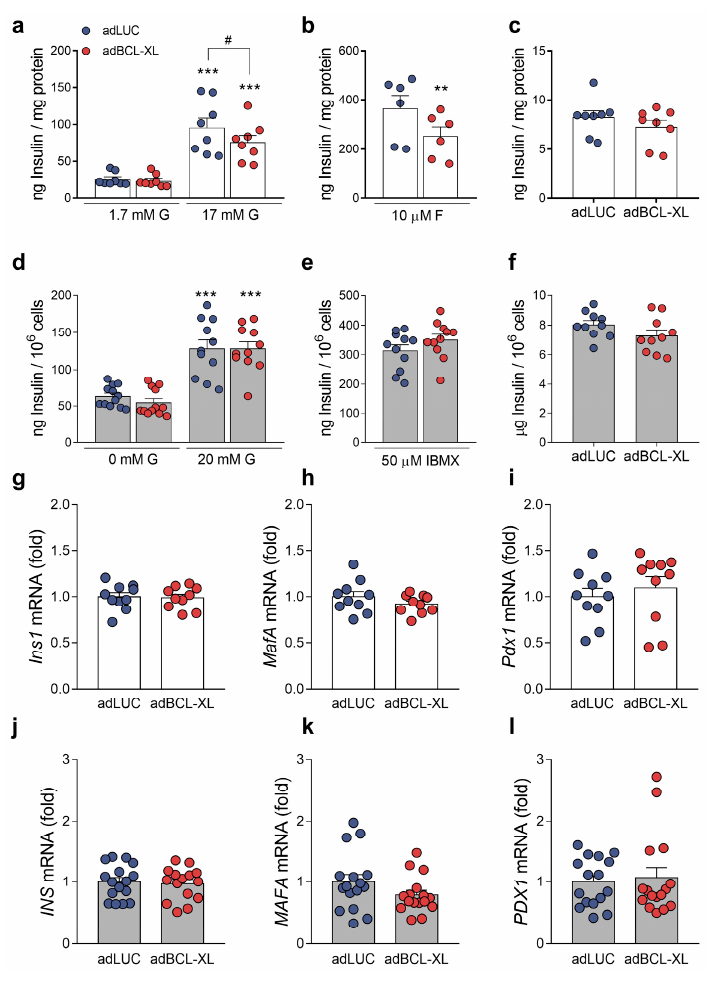
Figure 3. BCL-XL overexpression decreases insulin secretion in rat but not in human β -cells. INS-1E ( a – e , white bars) and EndoC- β H1 cells ( f – j , grey bars) were infected with adenoviral (ad) vectors encoding luciferase (adLUC, blue dots) or rat BCL-XL (adBCL-XL, red dots). After 48 h of recovery, glucose-stimulated insulin secretion was assessed. ( a , b ) Insulin secretion was measured at 1.7 and 17 mM glucose ( a ) or 17 mM + 10 μ M Forskolin (10 μ M F) ( b ). ( d , e ) Insulin secretion was measured at 0 and 20 mM glucose ( d ) or 20 mM + 50 μ M IBMX ( e ). ( c , f ) Insulin content in cell-free lysates in INS-1E ( c ) and EndoC- β H1 cells ( f ). Insulin secretion and insulin content were measured by ELISA. ( g – i ) mRNA expressions of Ins1 ( g ), Mafa ( h ), and Pdx1 ( i ) were analyzed by RT-qPCR and normalized by Gapdh in INS-1E cells. ( j – l ) mRNA expressions of INS ( j ), MAFA ( k ), and PDX1 ( l ) were analyzed by RT-qPCR and normalized by β -actin in EndoC- β H1 cells. Results are the means ± SEM of the 6 to 16 independent experiments, where each dot represents an independent experiment. ( a , d ) *** p ≤ 0.001 vs. low glucose (1.7 or 0 mM) and infected with the same adenoviral vector; # p ≤ 0.05 as indicated by bars. Two-way ANOVA. ( b ) ** p ≤ 0.01 vs. adLUC. Two-tailed Student’s t